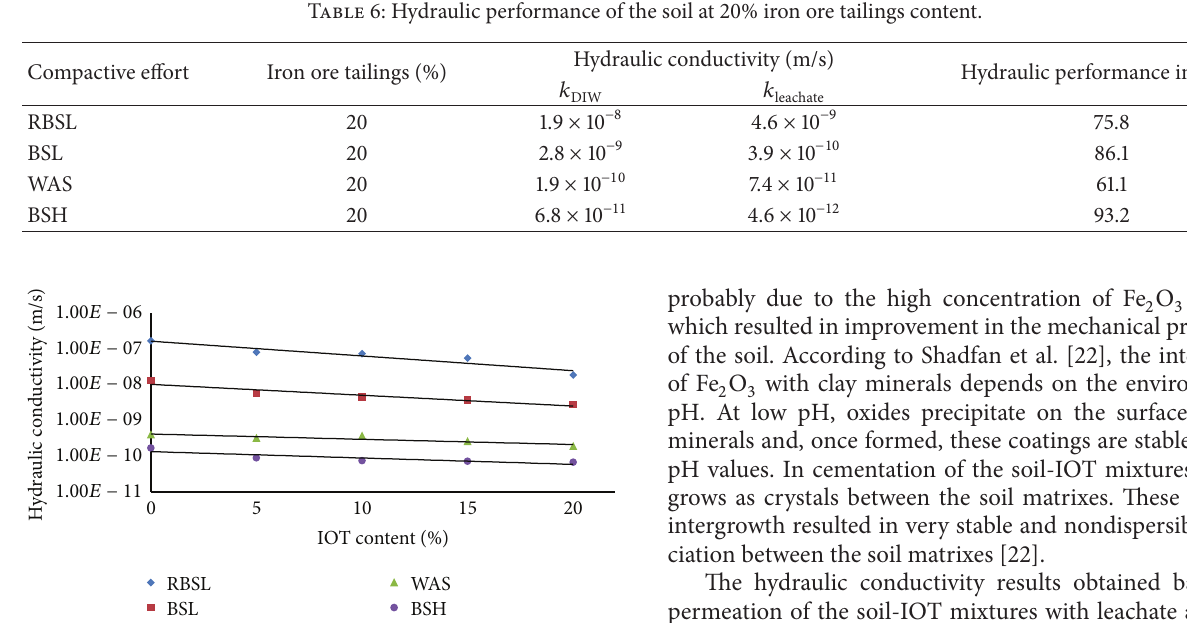
Figure 6: Hydraulic conductivity versus iron ore tailings content for compacted soil permeated with deionized water.